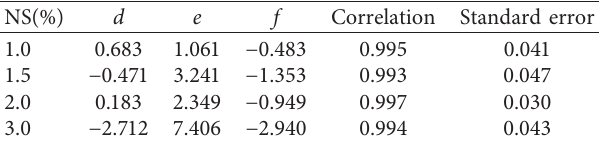
Table 8: Fitting parameters and correlation of cement pastes with different NS dosages.